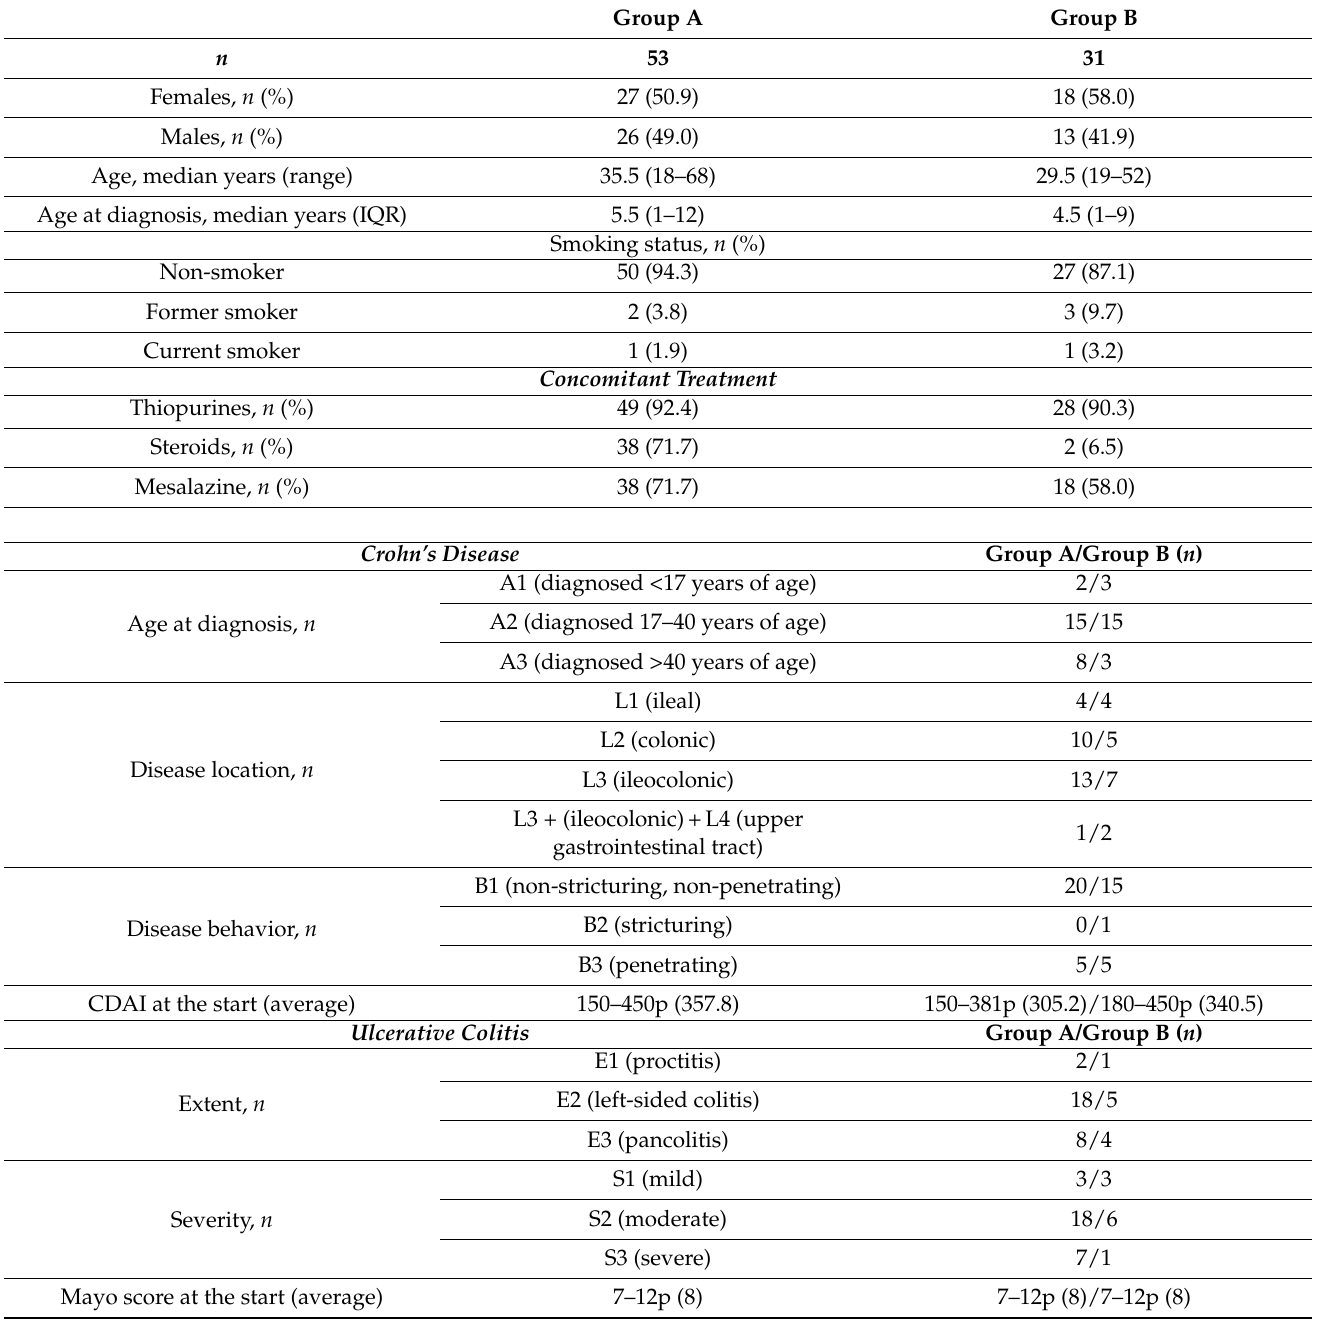
Table 1. Patient